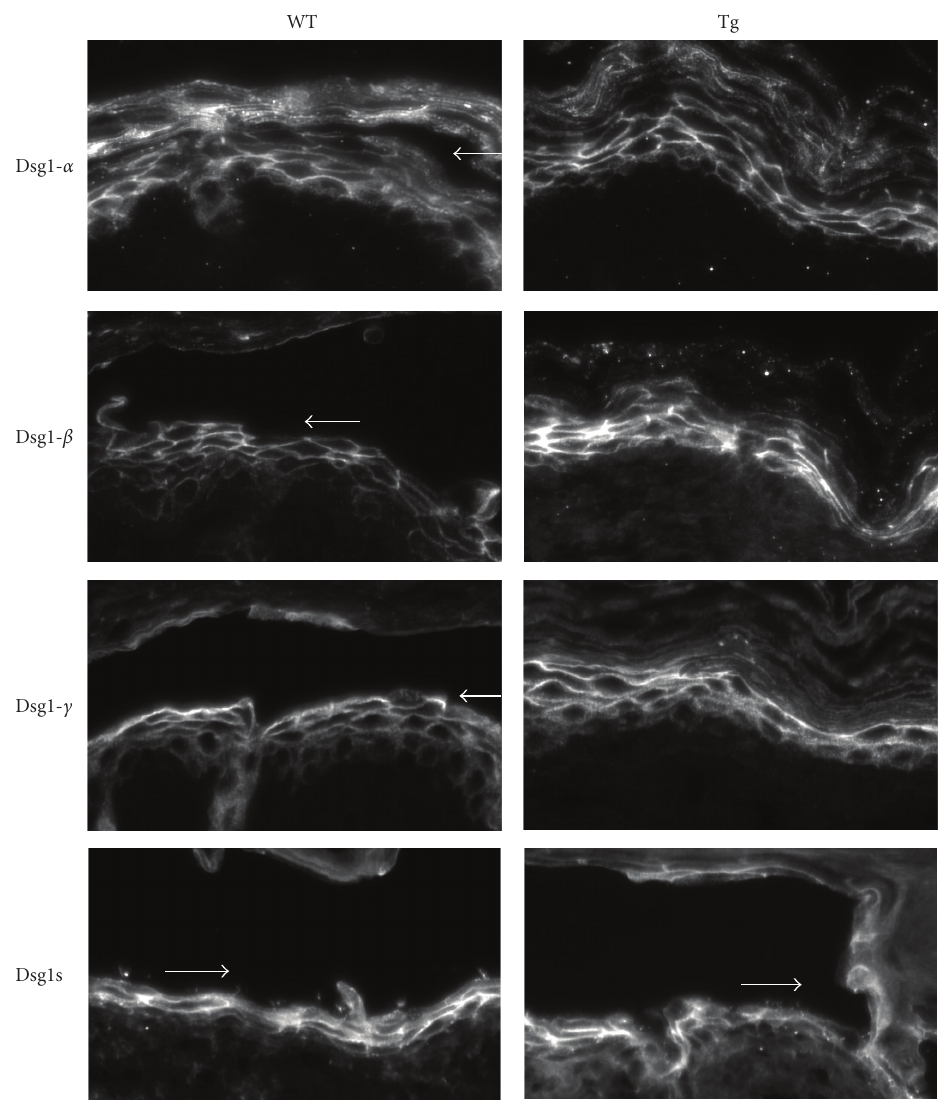
Figure 3: Dsg1 is maintained at the cell-cell border in ETA-treated epidermis. Formalin-fixed para ffi n-embedded skin sections from newborn WT and Tg mice treated with ETA, as described in Figure 2, were immunostained with antibodies AP61, AP498, Ab15, and 27B2. Antibodies AP61, AP498, and Ab15 were raised against the extracellular domain of Dsg1- α , Dsg1- β , and Dsg1- γ , respectively [17]. Immunofluorescence shows undisturbed cell-cell border staining of all Dsg1 isoforms in both WT and Tg skins treated with ETA. DAPI (blue) was used as a nuclear stain. Similar results were observed in skin treated with ETA for 18 hours. Arrows demarcate site of blister